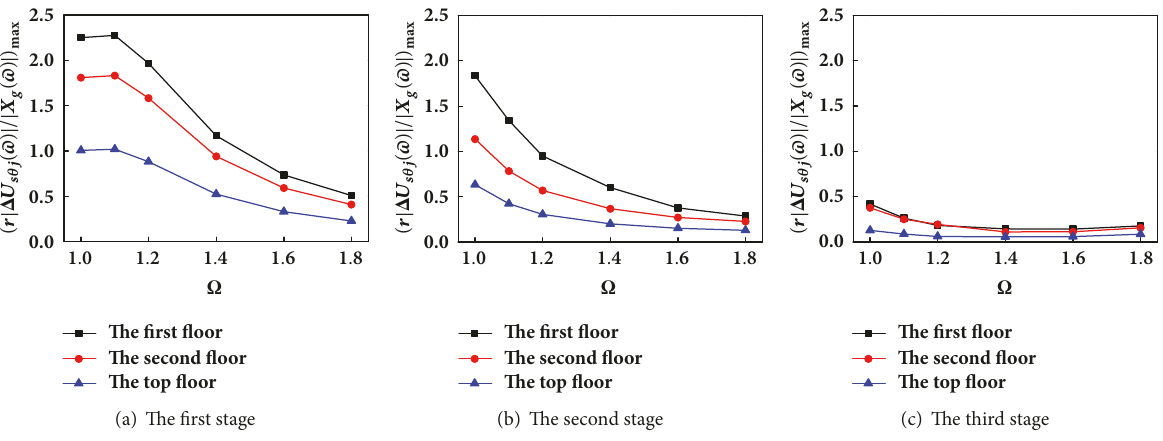
Figure 11: Interstory torsion displacement under different Ω